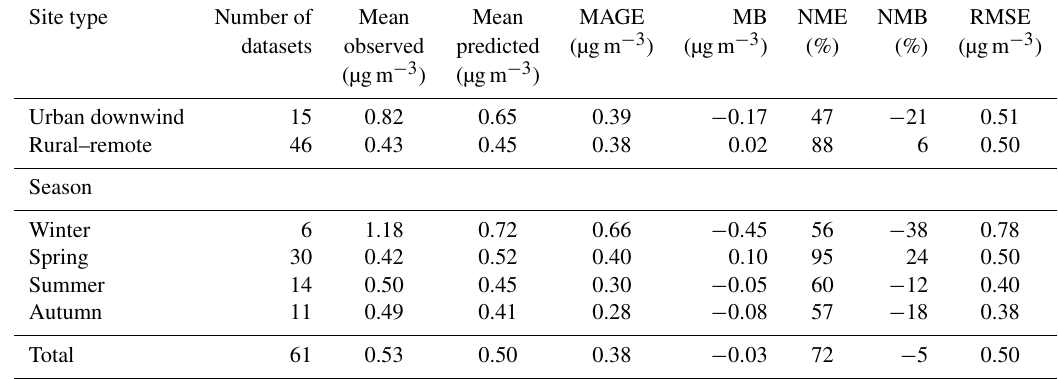
Table 1. Statistical evaluation of EMAC POA against AMS POA (sum of HOA and BBOA) from 61 datasets worldwide during 2001–2010. Site type